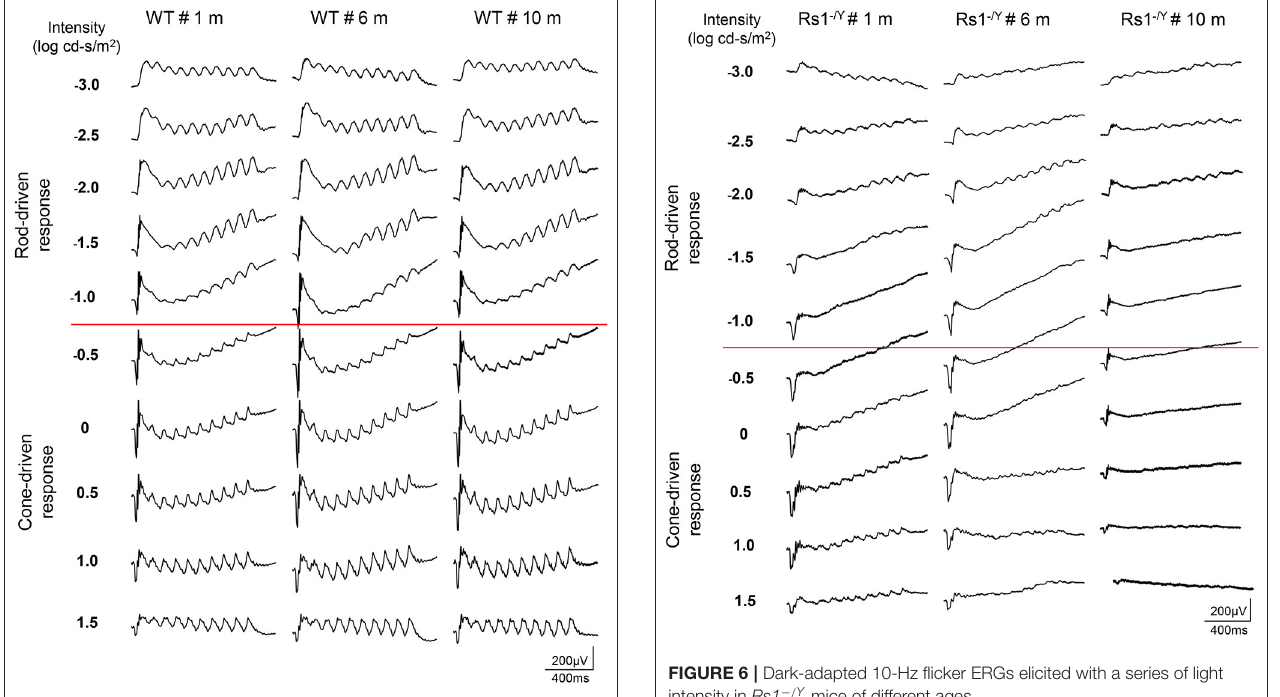
FIGURE 5 | Dark-adapted 10-Hz flicker ERGs elicited with a series of light intensity in WT mice of different ages.